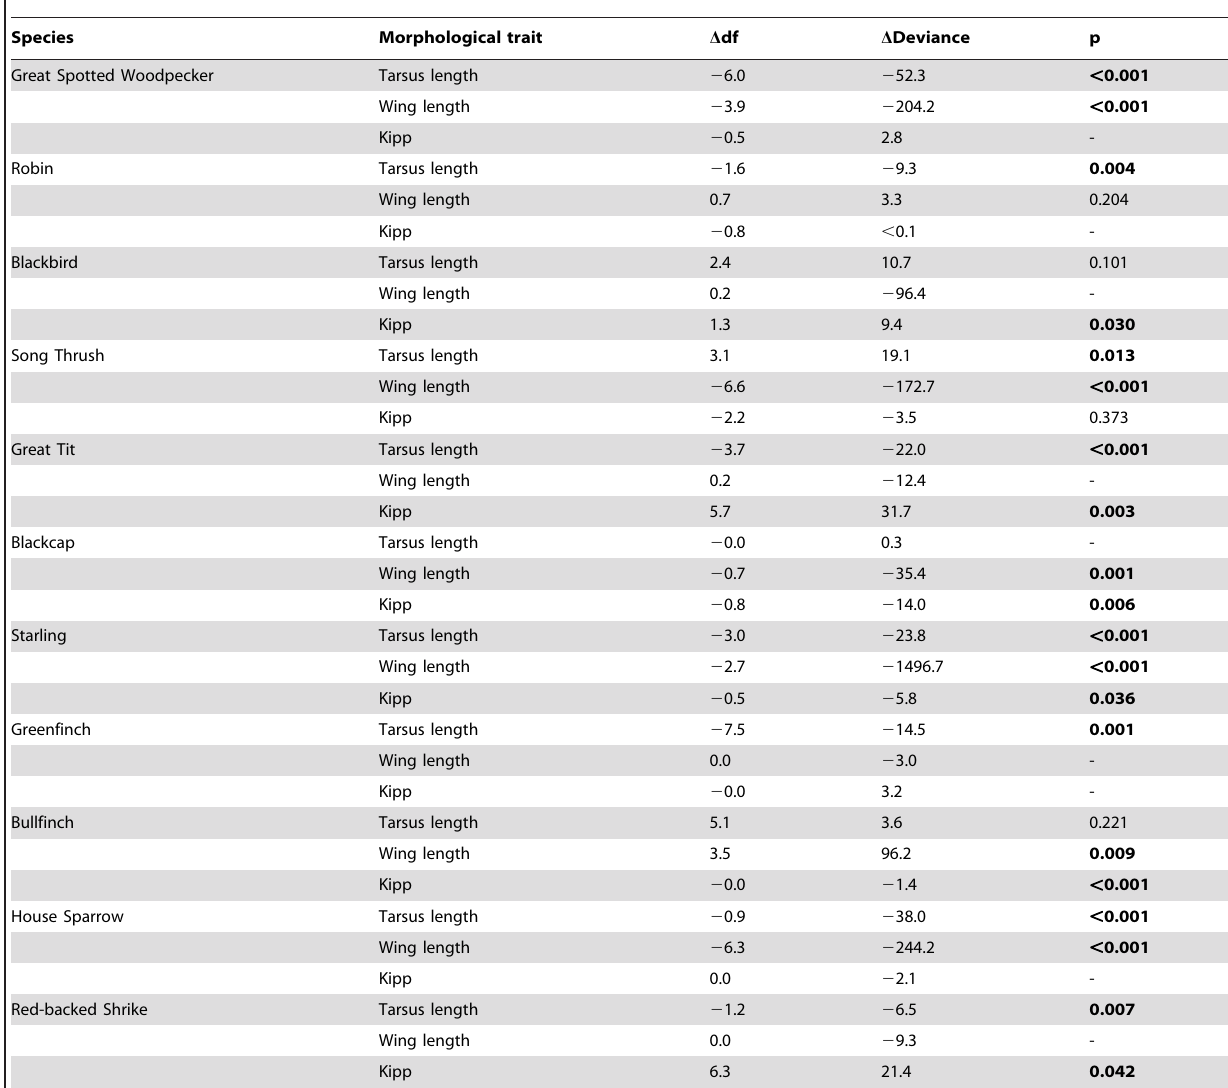
Table 4. Comparisons of models with alternate smooth terms (temperature – year) for each species and morphological trait.